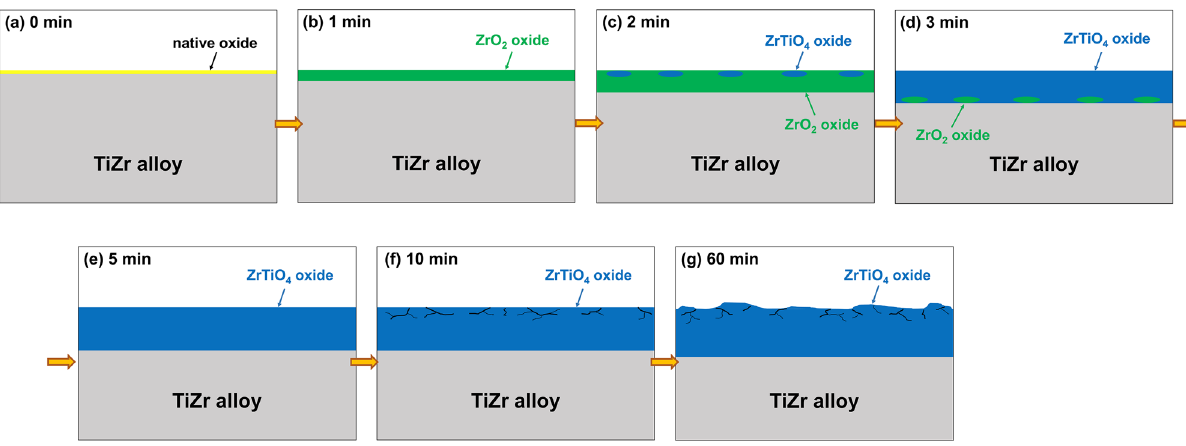
Figure 7. Evolution of the oxide film formed on the surface of the TiZr alloy during the heat treatment at 600 °C for ( a ) 0, ( b ) 1, ( c ) 2, ( d ) 3, ( e ) 5, ( f ) 10, and ( g ) 60